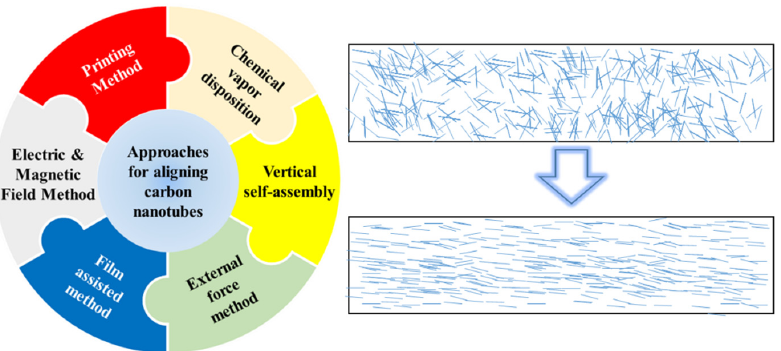
Figure 1. The approaches for aligning CNTs and the schematics of unordered and ordered